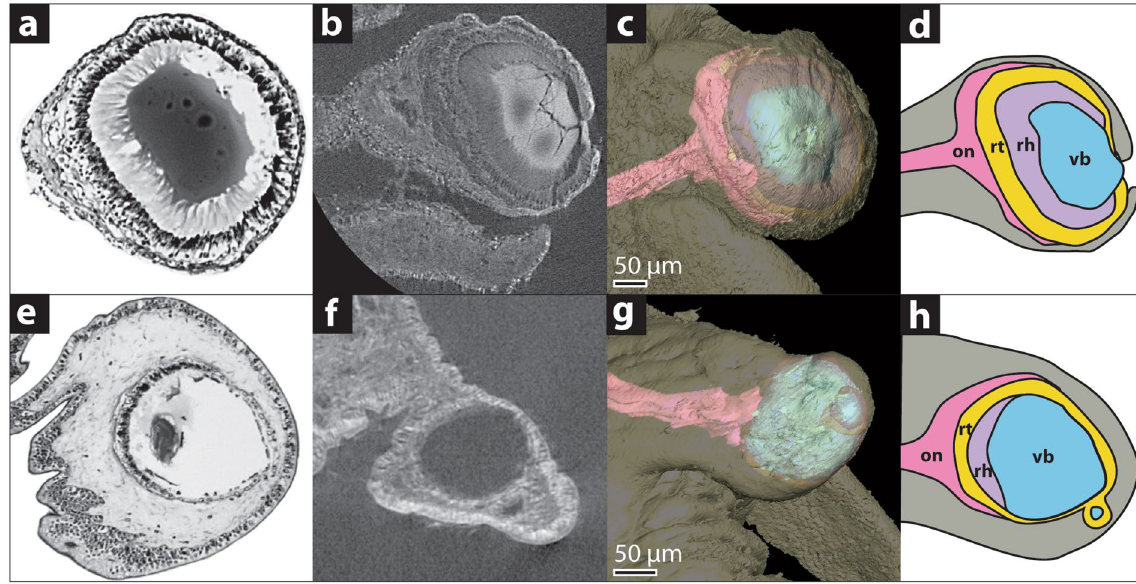
Figure 2. Micro-CT scans can produce comparable results to conventional histological techniques. ( a – d ) Ilanga navakaensis , an eyed shallow-water species. ( e – h ) Bathymophila diadema a deep-water species exhibiting eye reduction. ( a , e ) Histological sections. ( b , f ) μ -CT slices after PTA-staining. ( c , g ) Tomographic reconstructions based on μ -CT. ( d , h ) Schematic diagrams based on histological